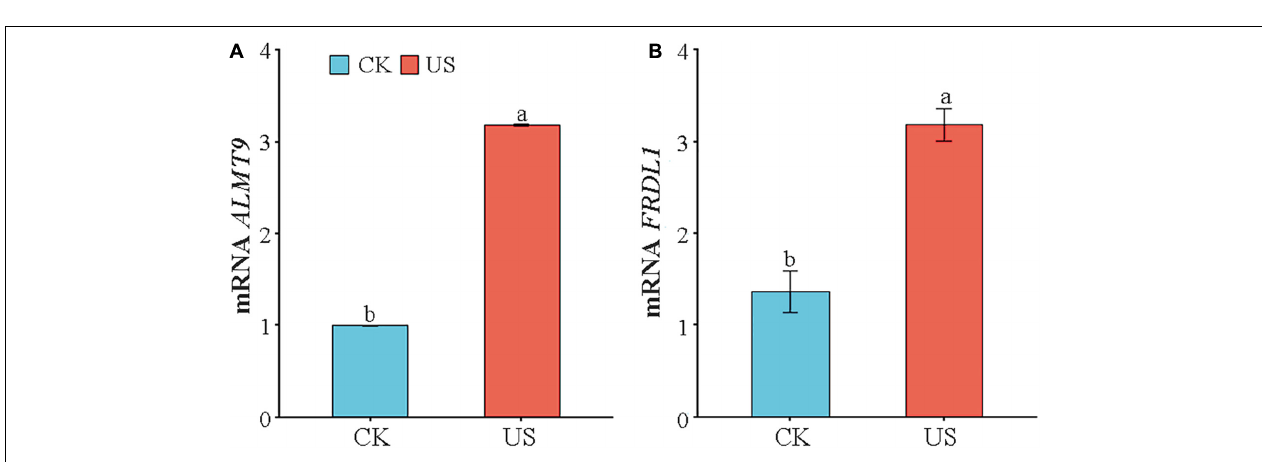
FIGURE 2 | Ultrasonic (US) treatment improved Al resistance in peanut. (A) Photography was performed after 5 days of Al treatment at room temperature. (B) Zn contents in leaves and grains in fragrant rice. Plant height (C) and main root length (D) were measured after 5 days of Al treatment at room temperature. Marking the same letters means P ≥ 0.05 (LSD), and there is no significant difference; the difference between different letters means P < 0.05 (LSD), and the difference is significant.